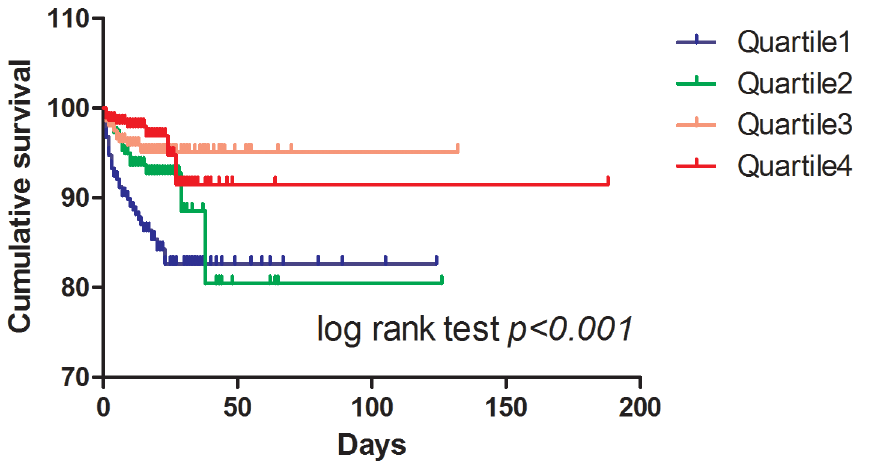
Figure 2. Kaplan-Meier curves for in-hospital cumulative mortality according to serum calcium of admission. Patients were stratified by quartiles of serum calcium. The comparisons among the groups were performed using the log rank test.